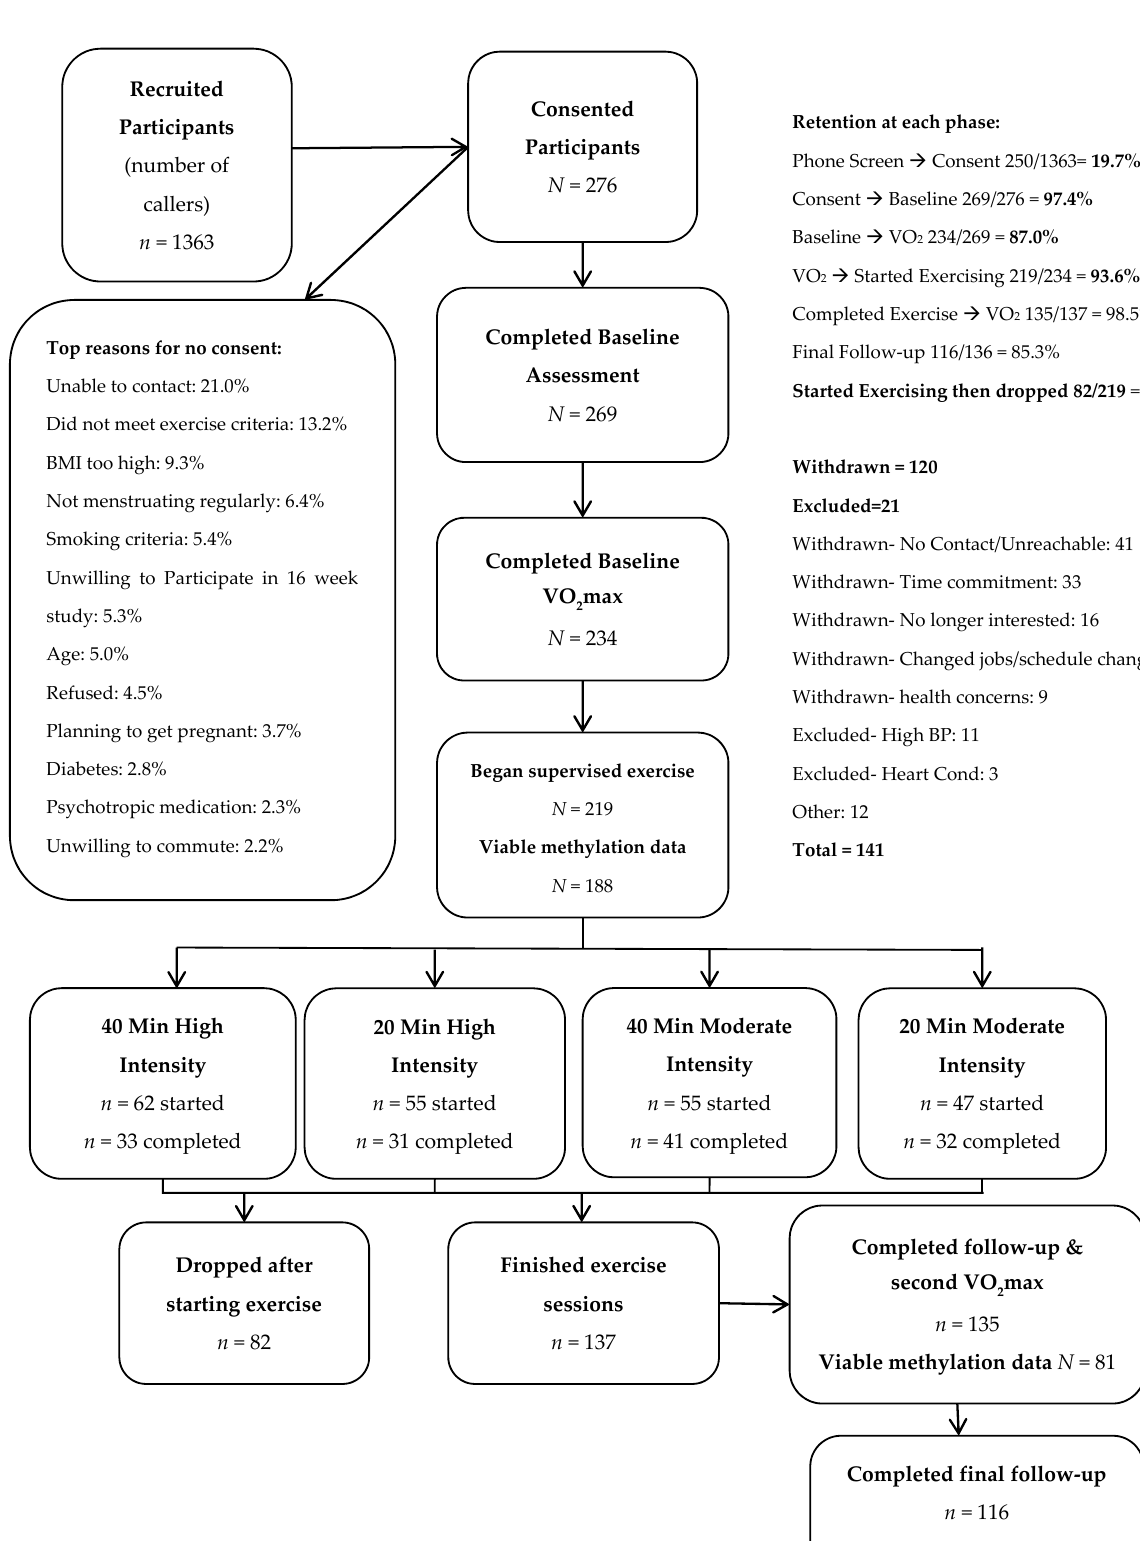
Figure 1. CONSORT diagram of participant flow throughout